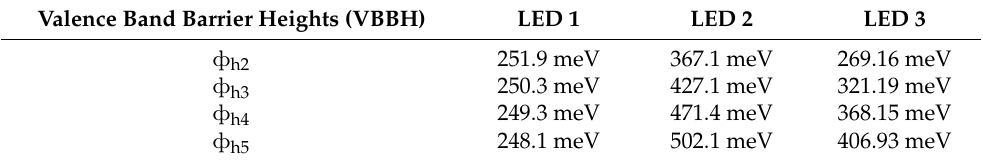
Table 2. Effective valence band barrier heights (VBBH) of QBs ( ф hn ) for LED 1, LED 2, and LED 3. Valence Band Barrier Heights (VBBH)